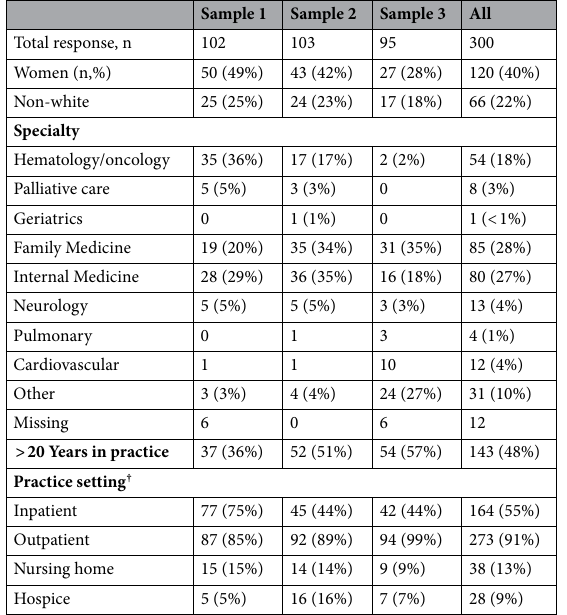
Table 3. Characteristics of Survey Respondents, N = 300. † Categories for practice settings are not mutually exclusive, thus one could report multiple